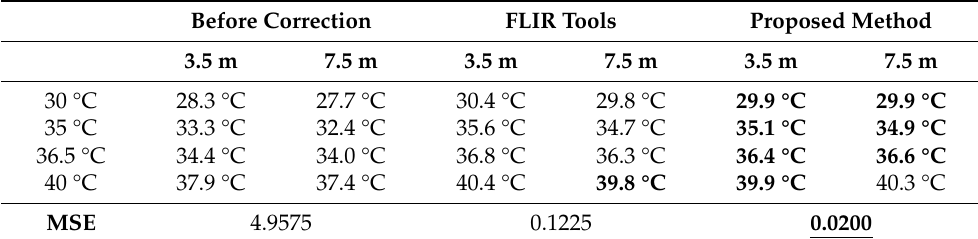
Table 7. Comparison of temperature estimates at approximately 3.5 m and 7.5